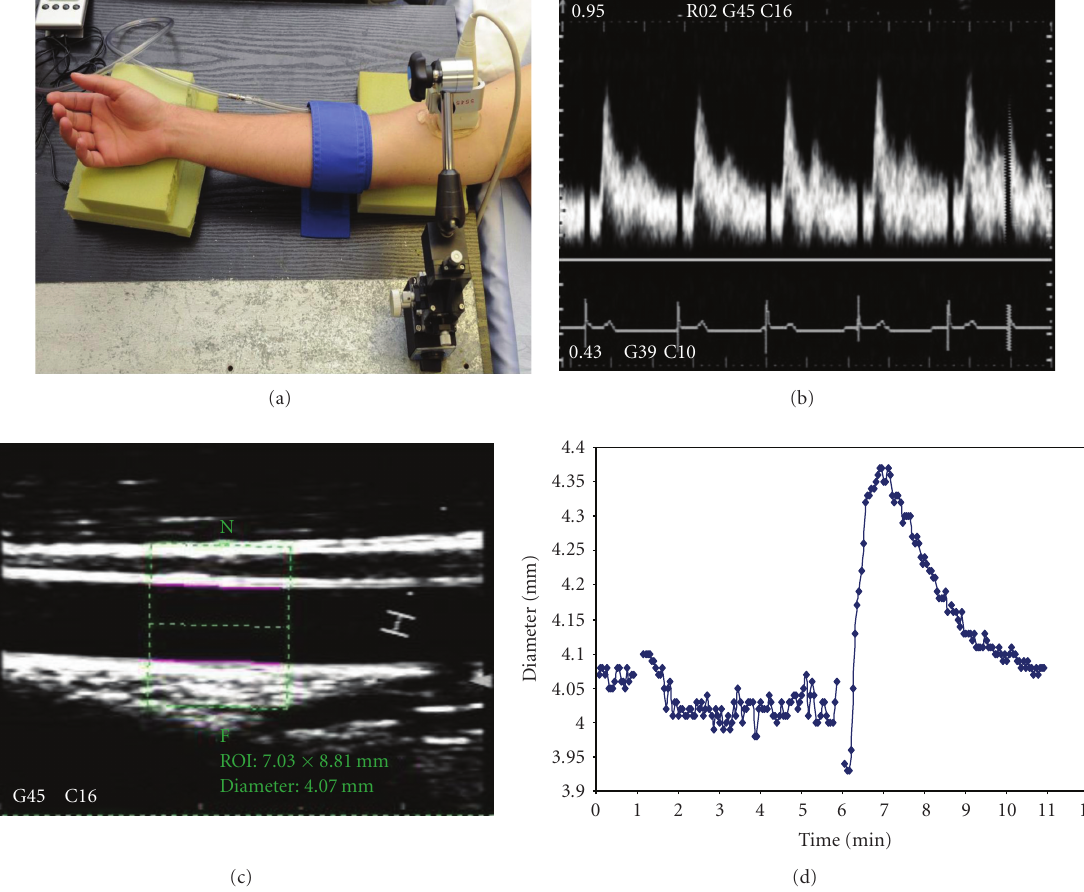
Figure 1: Setup and representative data for ultrasound evaluation of brachial FMD. (a) A sterotatic clamp with micrometer adjustment is used to hold the ultrasound probe. The occluding cu ff is positioned just below the elbow. (b) Doppler trace showing flow velocity profile during early reactive hyperemia. (c) B-mode image of brachial artery demonstrating selection of region of interest and edge-detection analysis with Brachial analyzer software package. (d) Brachial artery diameter profile during FMD protocol as measured using brachial analyzer the software package (0-1 minute baseline, 1–6 minutes cu ff up, 6–11 minutes response to reactive hyperemia